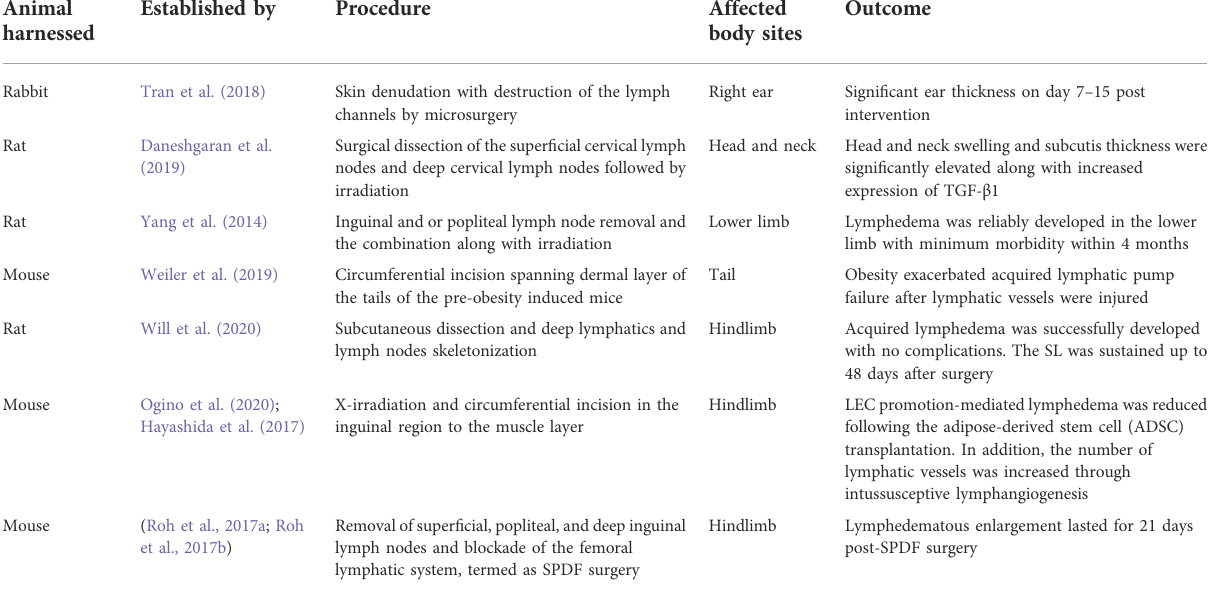
TABLE 2 Development of animal models of lymphedema. Animal